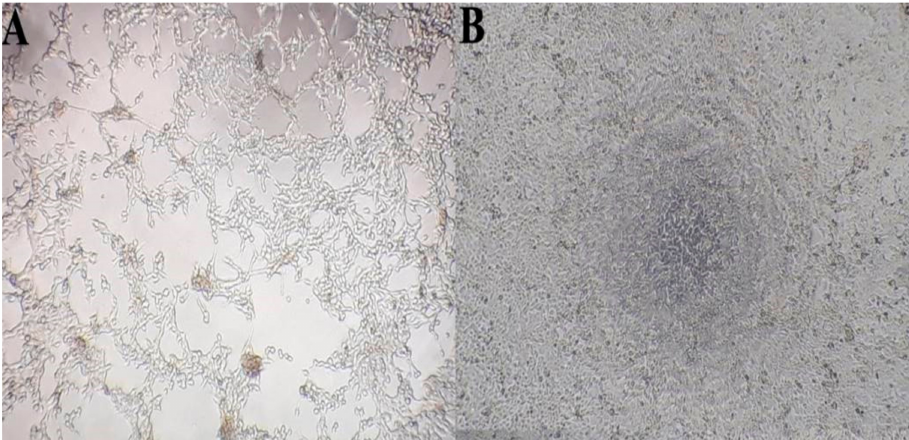
Figure 1. Cytopatheic e ff ect induced by the Bovine parainfluenza virus (BPIV)_3c isolate on MDBK cells 300 dpi. (Magnification: 400x). A : Infected cells; large areas of the monolayer have lysed. B : negative control.